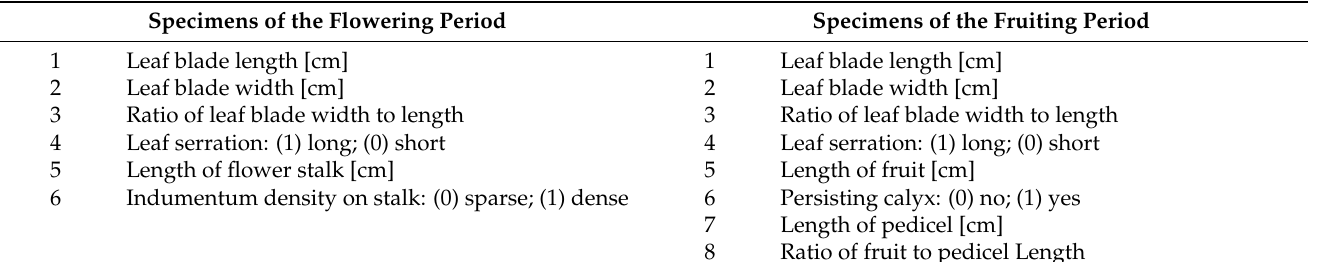
Table 1. Morphological characteristics used in the principal coordinate analysis and their